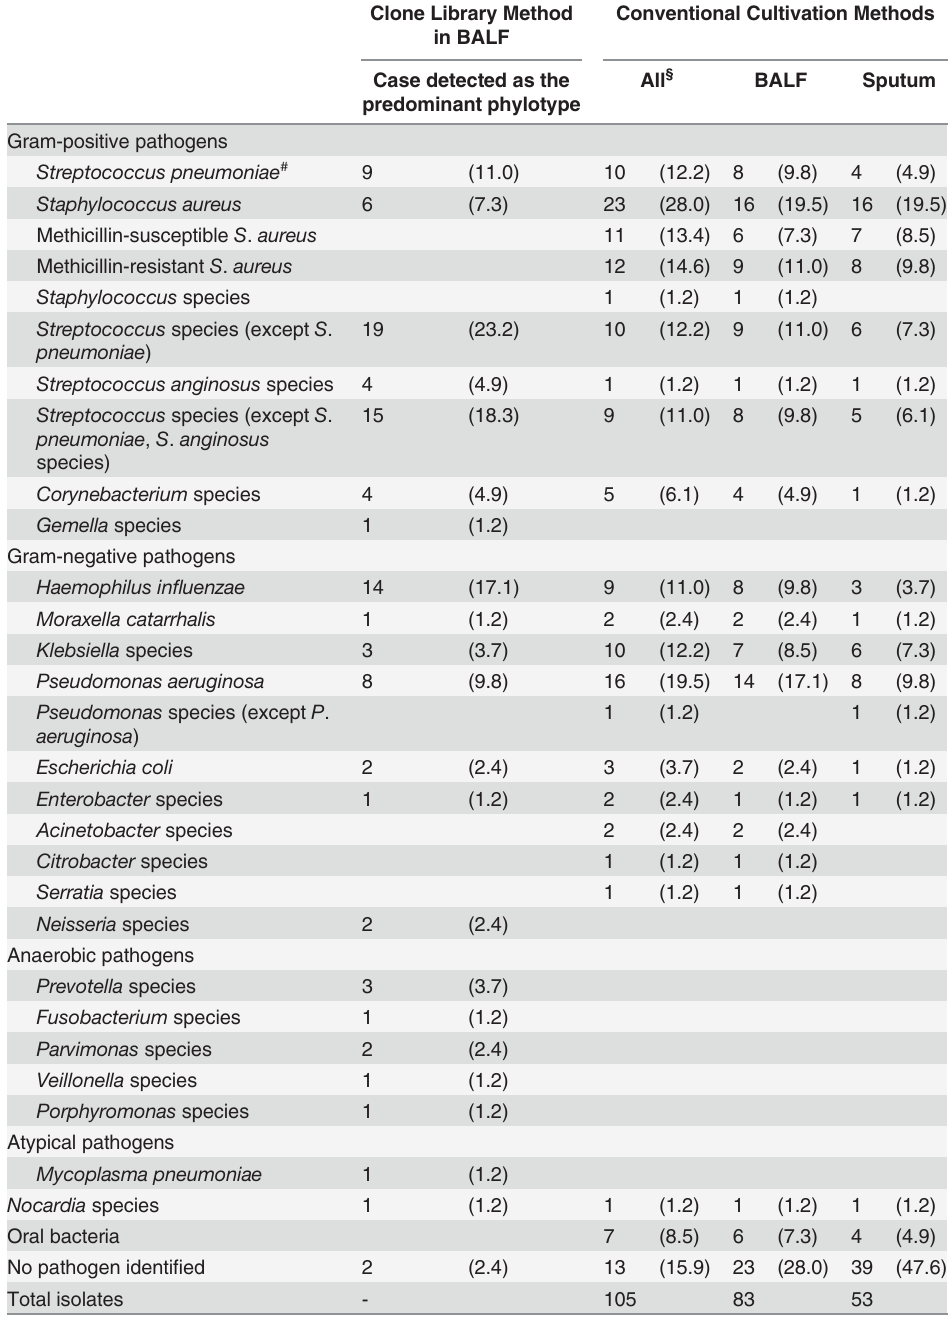
Table 2. Predominant bacteria according to the molecular method and conventional cultivation methods.